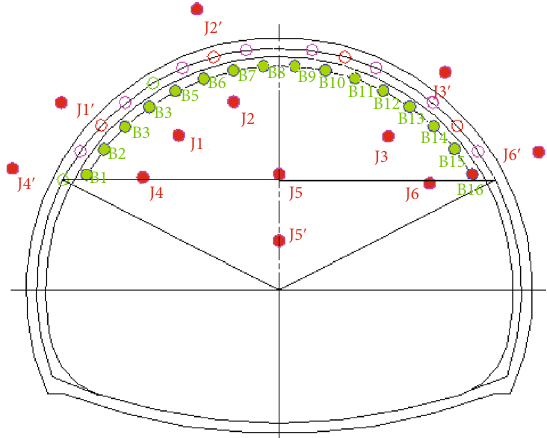
Figure 13: Layout of detection hole. J1 ~ J6 in the fi gure is the opening position of the inspection hole, and J1 ′ ~ J6 ′ is the fi nal hole position. Table 3: Completion rate of boreholes. Depth of the Number hole